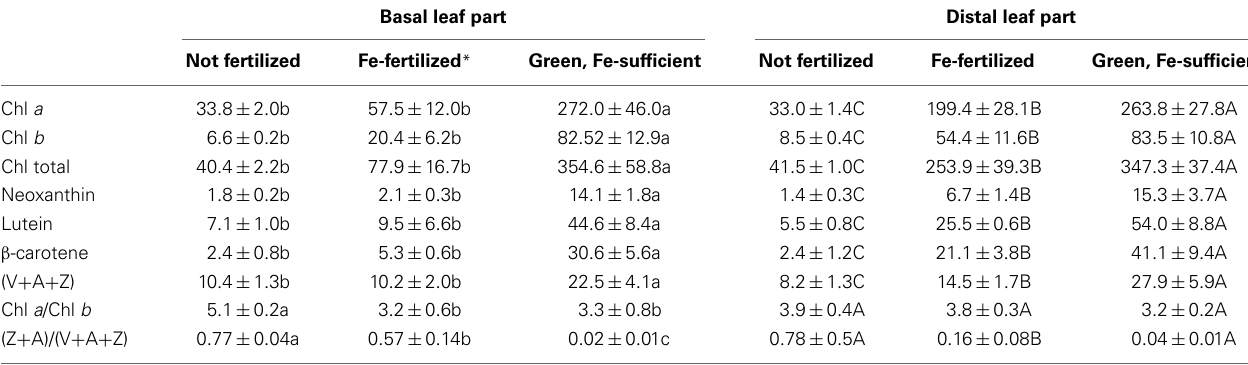
The pigment concentrations of leaves from Fe-sufficient plants are also shown for comparison. Data are means ± SE (n = 4 plants; each sample was composed of two leaves from the same plant). Values followed by the same letter within the same row were not significantly different (Duncan test) at the p ≤ 0.05 level. Columns with data corresponding to Fe-fertilized leaves are labeled “Fe-fertilized” in case of the treated (distal) leaf area and “Fe-fertilized * ” in case of the (basal) untreated area.